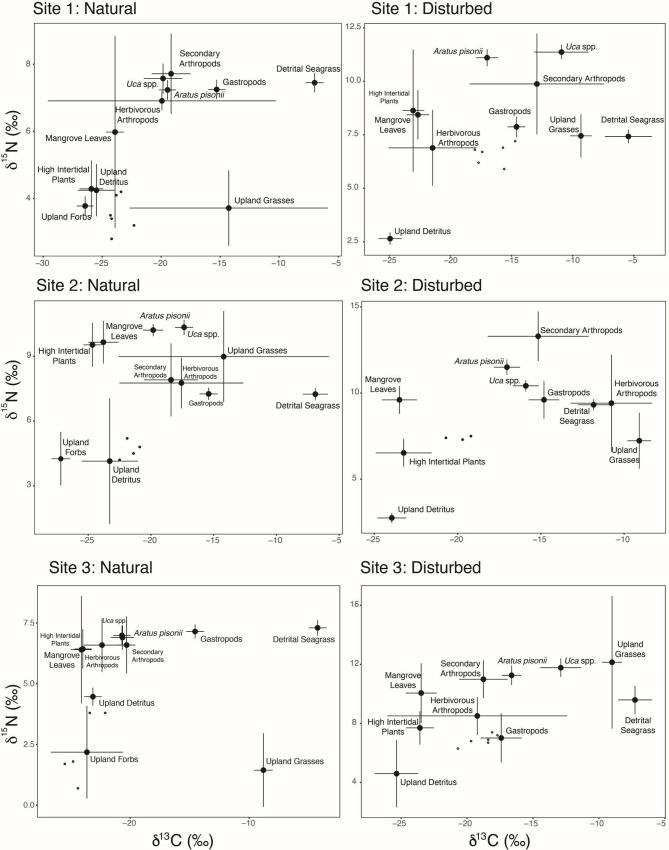
Biplots of all Armases δ13C and δ15N isotope signatures plotted with site-specific source groups (mean ± s.d.).